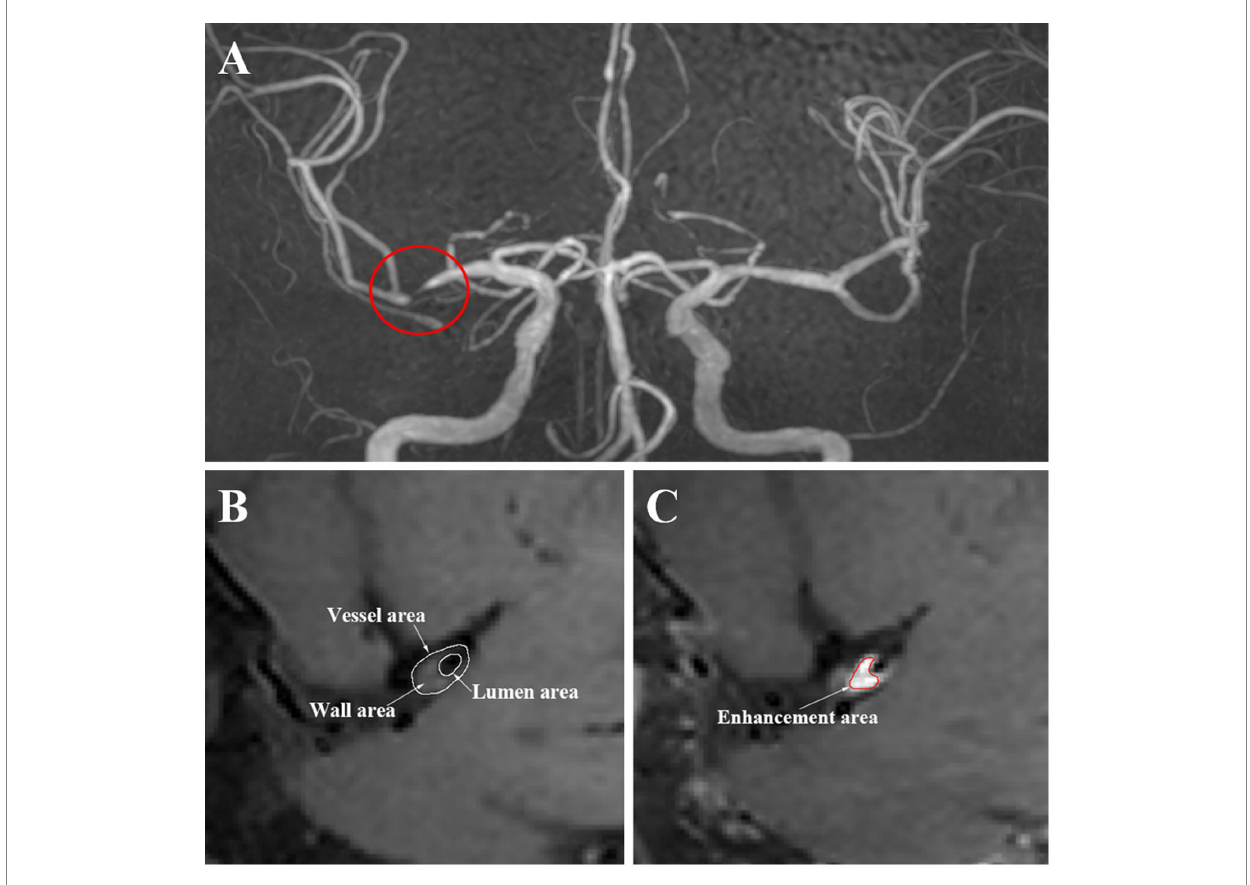
FIGURE 1 Illustration of HR-MRI arterial